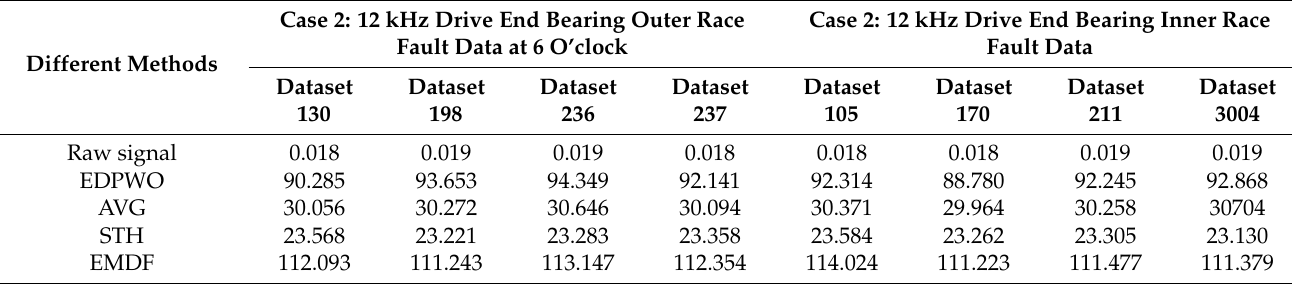
Table 11. The CPU time obtained by various methods under different CWRU fault data(s).